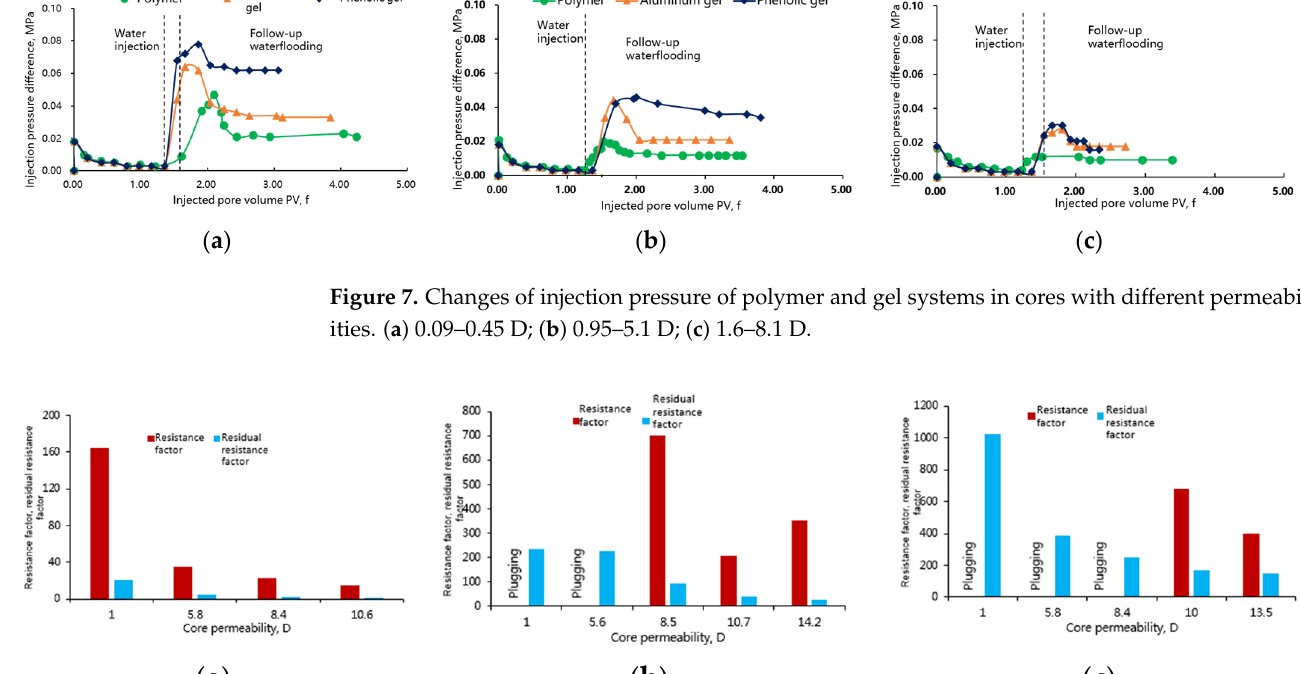
Figure 8. Resistance factor and residual resistance factor of polymer and gel systems in sand-packed cores. ( a ) Polymer; ( b ) Phenolic gel; ( c ) Aluminum gel.